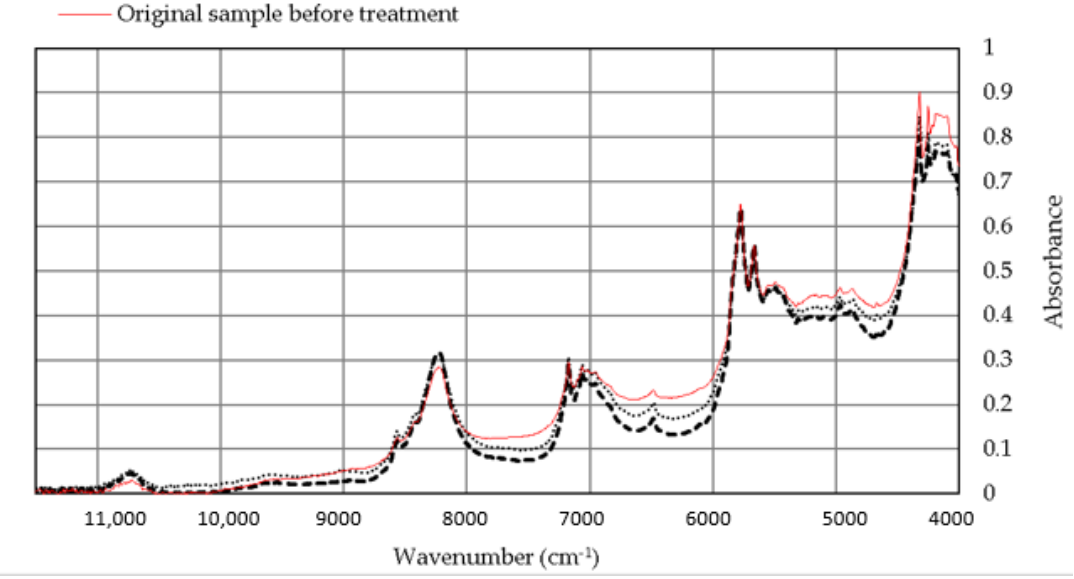
Figure 3. The near infrared (NIR) spectra of high-density polyethylene (HD-PE) samples before and after undergoing SCE.